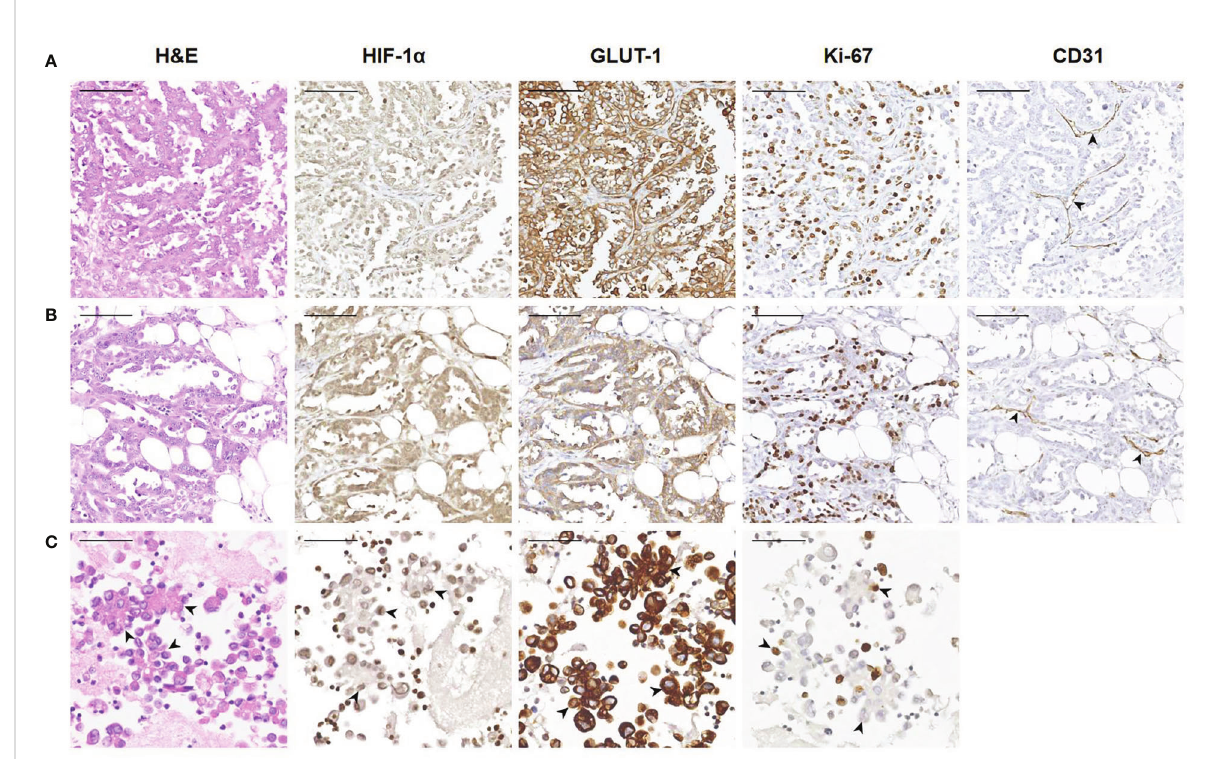
FIGURE 4 Representative images showing HIF-1 a , GLUT-1 and Ki-67 expression of human ovarian cancer between tumor cells in ascites with corresponding primary and peritoneal lesions. A 60-year-old woman was diagnosed with high-grade serous carcinoma of the ovary. (A) H&E and immunohistochemical staining show the tumor cells in the ovary (200×). The tumor cells are arranged in a papillary or glandular pattern, and are HIF-1 a positive and GLUT-1 positive with a high Ki-67 index. Through CD31 staining, several blood vessels are identi fi ed in the stroma (black arrowheads). Bar , 100 m m. (B) Immunohistochemical results of tumor cells in a peritoneal metastasis (200×). Tumor cells in fi ltrate the adipose tissue, and are also HIF-1 a positive and GLUT-1 positive with a high Ki-67 index. Blood vessels are visible (black arrowheads). Bar ,